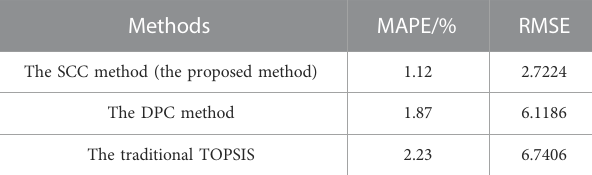
TABLE 5 Prediction errors of the three coef fi cient methods.